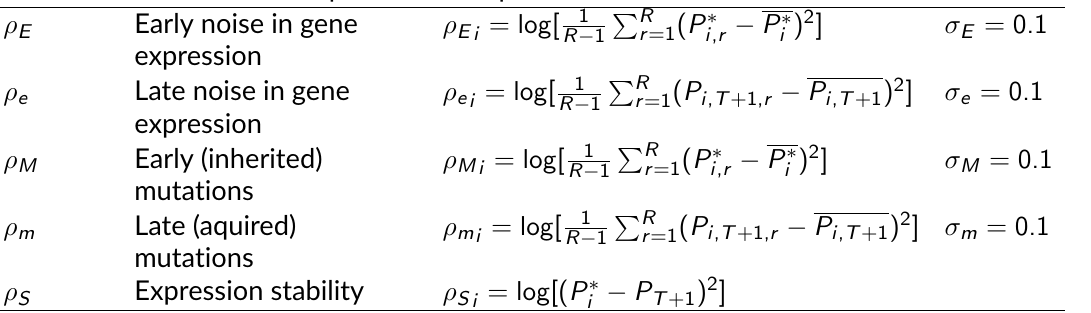
Table 1 – Summarized calculation of all five robustness indicators. Index i stands for the i n ), and r for the replicate ( 1 r R ), since all indicators except ρ S were gene ( 1 ≤ ≤ ≤ ≤ estimated by a resampling procedure. P ∗ i stands for the equilibrium gene expression of R P ∗ gene i (mean expression from the last τ time steps), and P ∗ i = (1 / R ) i , r represents r =1 the mean over replicates. Noise in gene expression was simulated by adding a random P Gaussian deviation to the initial state P 0 of the network (for ρ E ) or to the last state P T of the network (for ρ e ). Mutations were simulated by adding a random deviation to a random interaction in the network W , either before starting the network dynamics ( ρ M ) or after the last time step ( ρ m ). All robustness indicators are homogeneous to a log variance in gene expression; robustness increases when the indicator gets smaller, and sensitivity increases when the indicator increases. The last column indicates the standard deviation of the corresponding Gaussian disturbance. Computation Std.